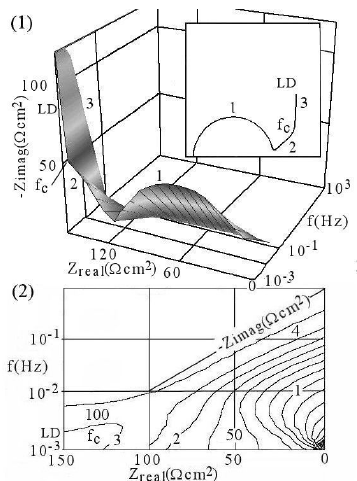
Figure 3. ( 1 ): Nyquist diagram for palladium charged in hydrogen. Applied potential: − 0.35 V/NHE, position towards reversible potential, LD: hydrogen blocking; ( 2 ): 3D contour graph, real impedance and frequency ( f ) in X–Z axes (lateral), imaginary impedance in dragging the y -axis